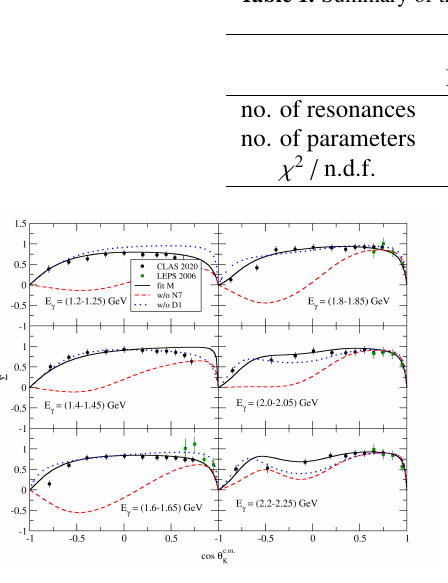
Figure 3. Photon beam asymmetry data as in Fig. 2, compared to "fit L" results (solid line). Same fit, with the K ∗ (892) (dash-dotted line), N (1720) 3 / 2 + (dashed line) and N (2060) 5 / 2 − (dotted line) resonances